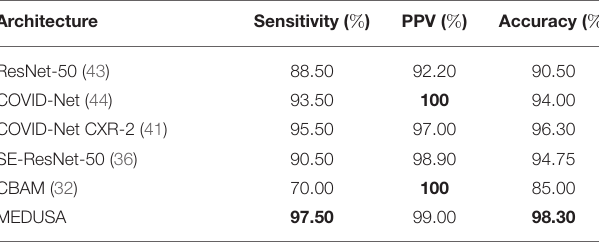
Best results are highlighted in bold.